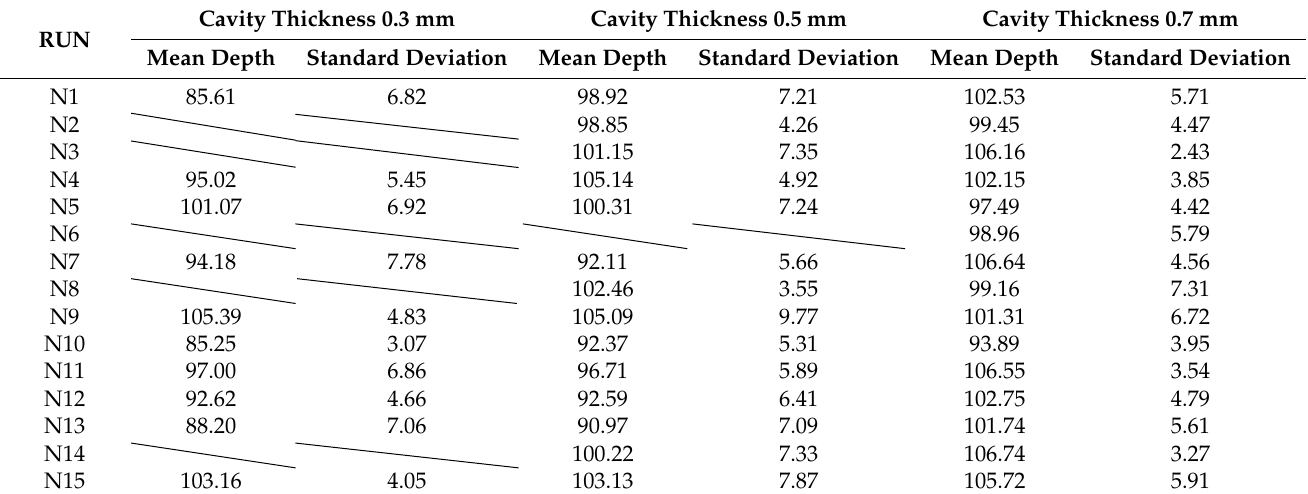
Table 4. Experimental results for three cavity